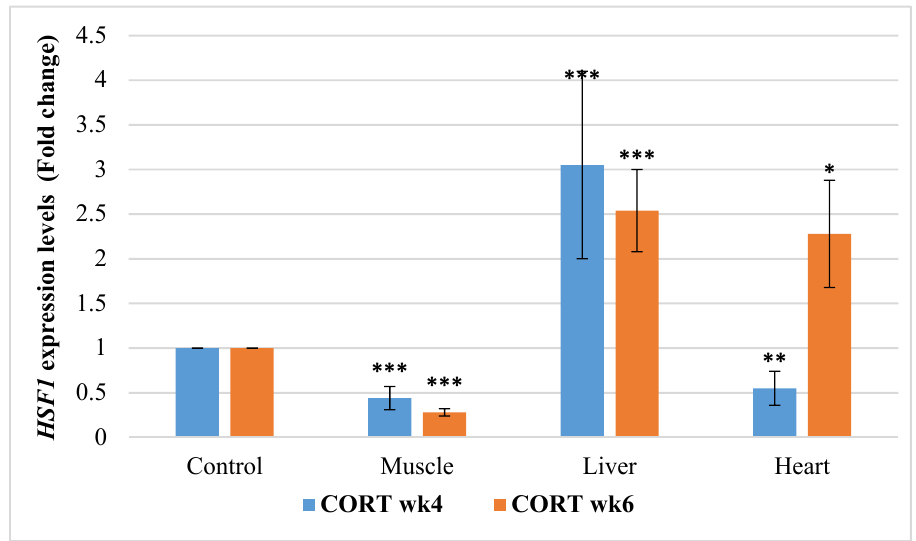
Figure 5. Expression profile of heat shock transcriptional factor 1 ( HSF1 ) in the muscle, liver, and heart at week 4 and 6 of corticosterone-fed chickens compared to the control (fold change). CORT wk4 = 4 weeks of age (2 weeks of CORT administration); CORT wk6 = 6 weeks of age (4 weeks of CORT administration); n = 20. Probability, * = p < 0.05; ** = p < 0.01; *** = p < 0.001.